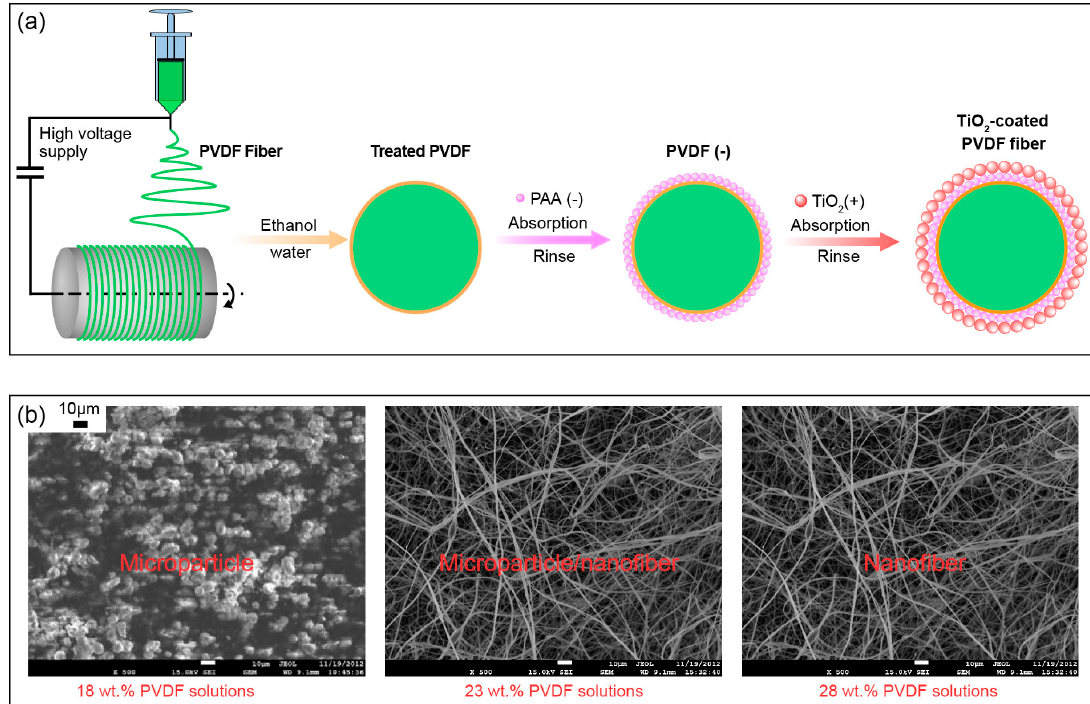
Figure 1. Preparations of TiO 2 -coated electrospun fibers. ( a ) Preparation process; ( b ) Influence of electrospinning parameters [34].